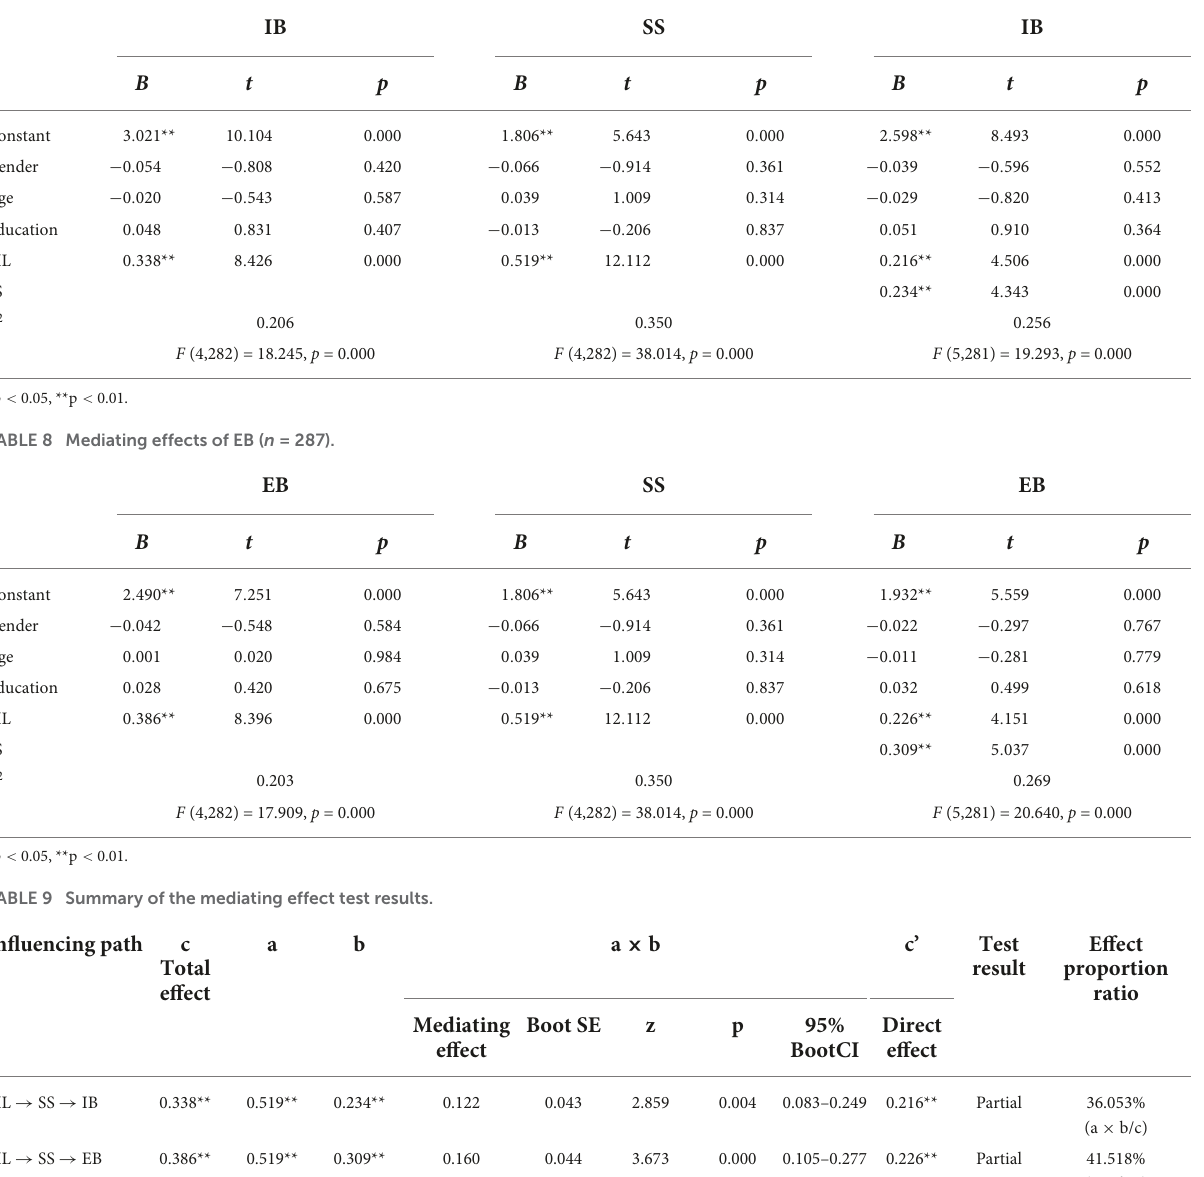
TABLE 7 Mediating effects of IB (n = 287).